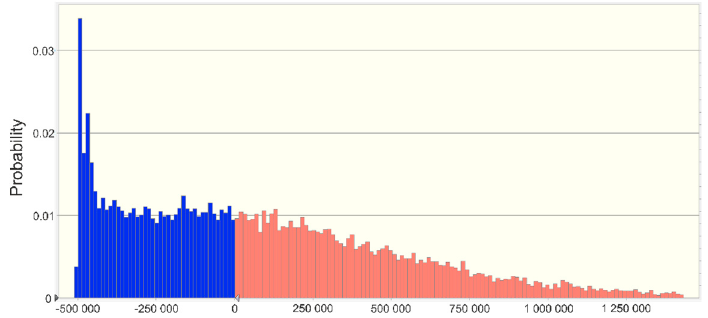
Figure 4. The distribution of the XNPV in the model with options. Source: own study.